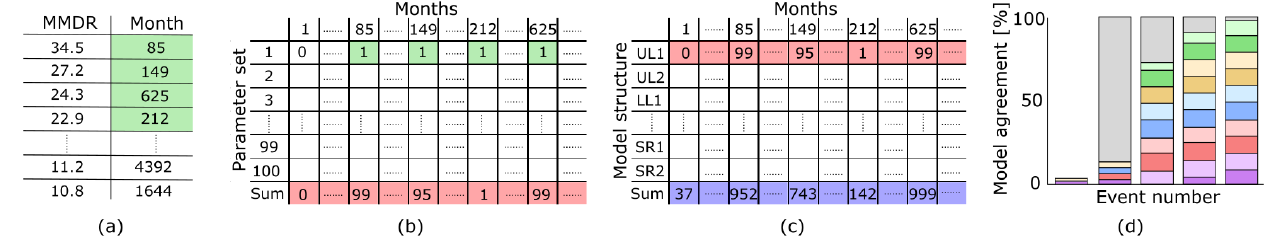
Figure 4. Illustration of the procedure for the comparison of the timing of extreme events, equal to or greater than 500-year events. (a) In each simulation, the monthly maximum daily runoff (MMDR) values were sorted and the four most extreme events were selected (green cells); this table shows an example for one parameter set. (b) All parameter sets of one model structure were concatenated, and the sum (red cells) indicated the variation in timing in one model structure. A score of 100 means that for all different parameter sets, the same event is selected. (c) All model structures of one climate zone were concatenated, and the sum (blue cells) indicated the variation in extreme event timing in all model structures for one climate zone. The values in the blue cells have a maximum score of 1000 (10 models, with 100 parameter samples each). A score of 1000 indicates that all models and all parameter sets identify the same event as a 500-year event (100% model agreement). Given that we have 2000 years of simulations and evaluate 500-year events, the ideal case where all models agree would result in four events with a score of 1000. (d) Stacked bar charts are used to visualise the model agreement of specific runoff events. Each row in panel (c) represents one colour in the coloured bars in panel (d) ; the total height of each bar is determined by the value in the blue cells in panel (c) . Grey shading behind the bars indicates the theoretical maximum for 500-year events: four runoff events with 100% model